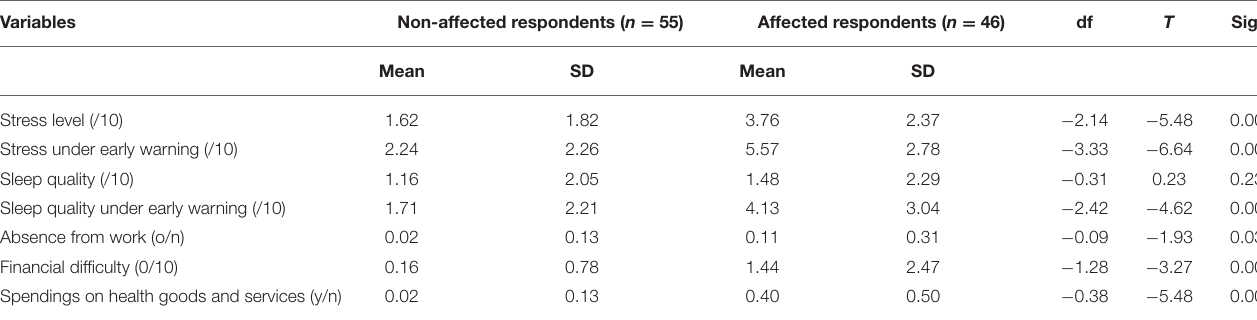
TABLE 3 | Descriptive and T -test comparison of affected and non-affected respondents ( n = 101). Variables